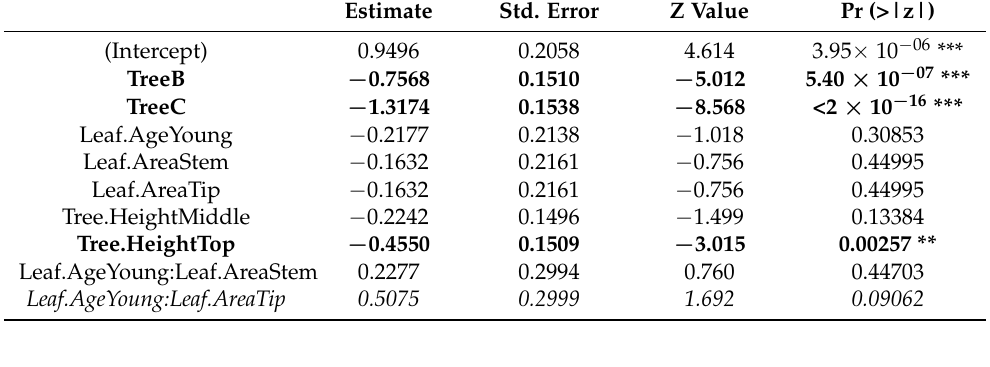
Table 1. Logistic regression model of Colletotrichum prevalence. Significant factors are highlighted in bold , marginally significant factors in italics . ** is for p < 0.01, *** is for p < 0.001.